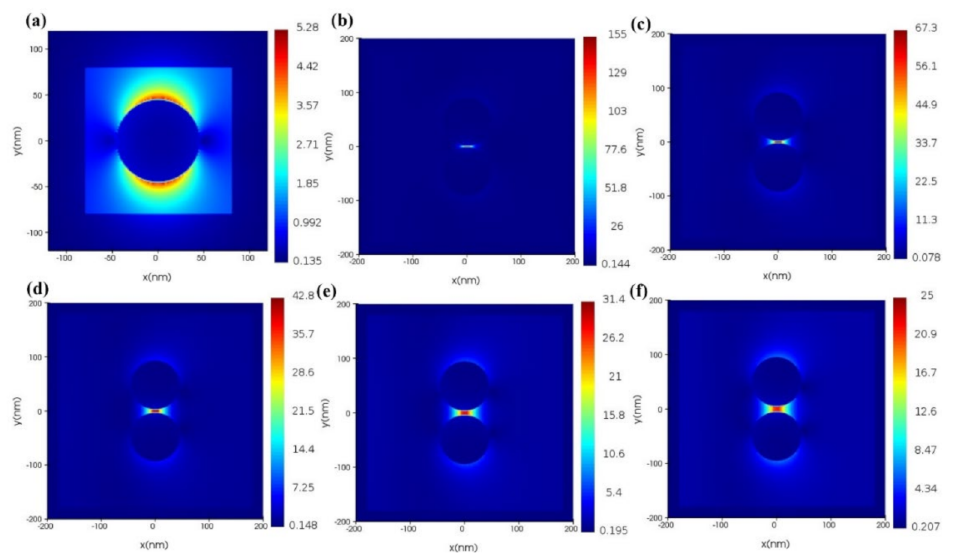
Figure 3. ( a ) FDTD simulated electric field at the excitation wavelength of 532.6 nm for single Ag NP with a radius of 45 nm and ( b – f ) double Ag NPs with different gap distances of 2, 4, 6, 8, and 10 nm,